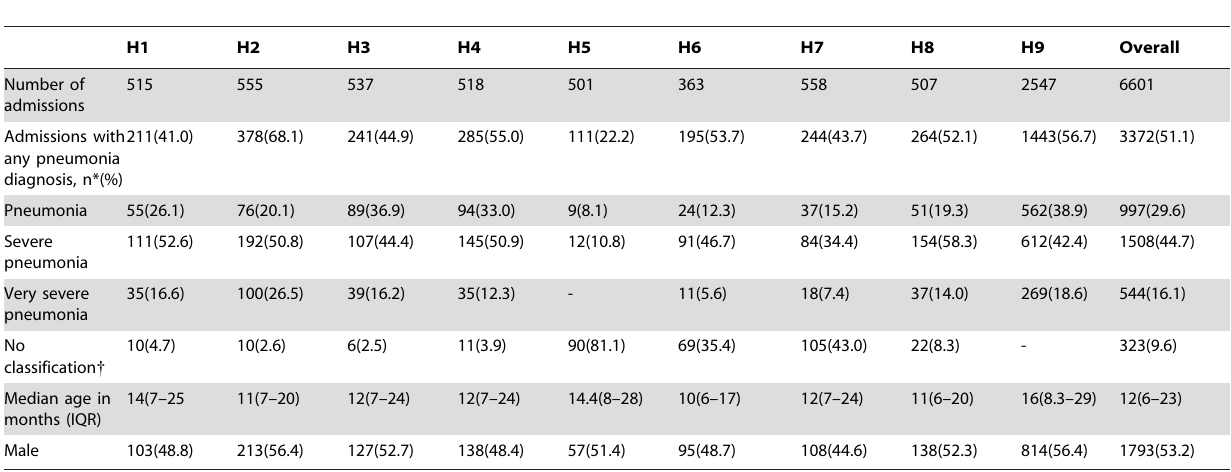
Table 1. Admissions aged 2–59 months at 9 Kenyan District Hospitals from March 2007 to March 2008 and characteristics of those with pneumonia